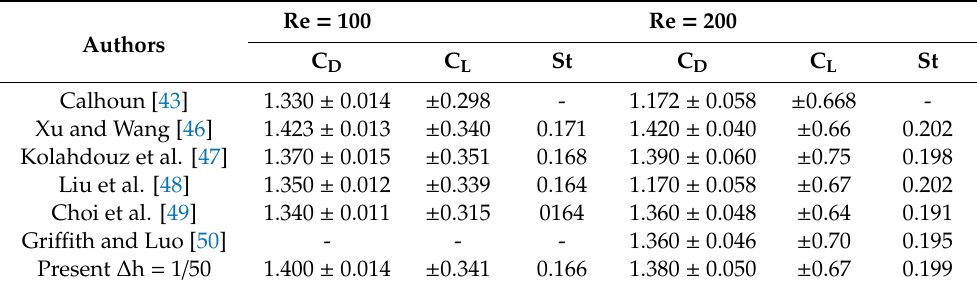
Table 2. Drag and lift coe ffi cients and Strouhal number for flow past a stationary cylinder at Re = 100 and Re =